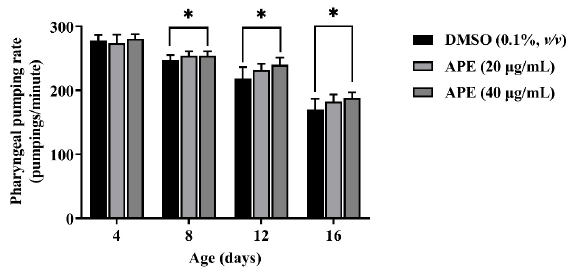
Figure 7. Effect of APE on age-related decline in pharyngeal pumping. It was observed that 40 µg/mL APE significantly attenuated the pharyngeal pumping rate in the C. elegans aging process.